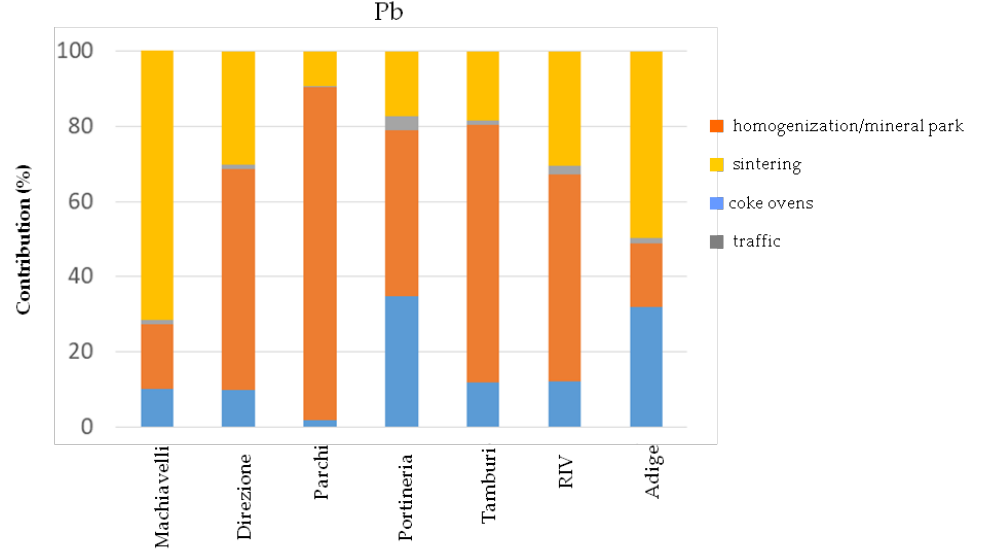
Figure 5. Percentage contribution of factors on B[a]P concentrations at the receptor sites.